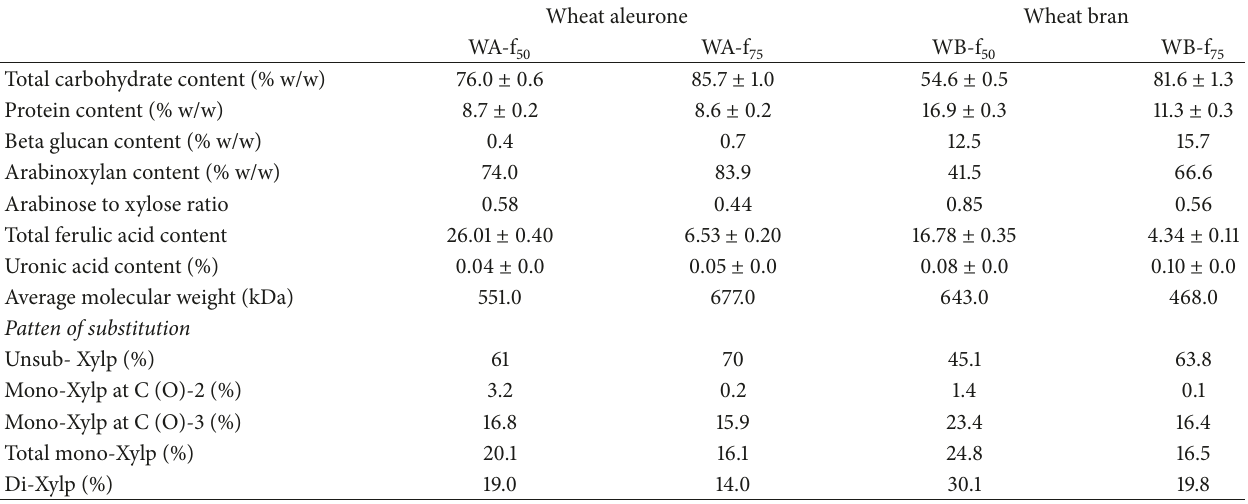
Table 1: Chemical composition and characteristics of water extractable arabinoxylan from wheat aleurone (WA) and wheat bran (WB). Wheat aleurone